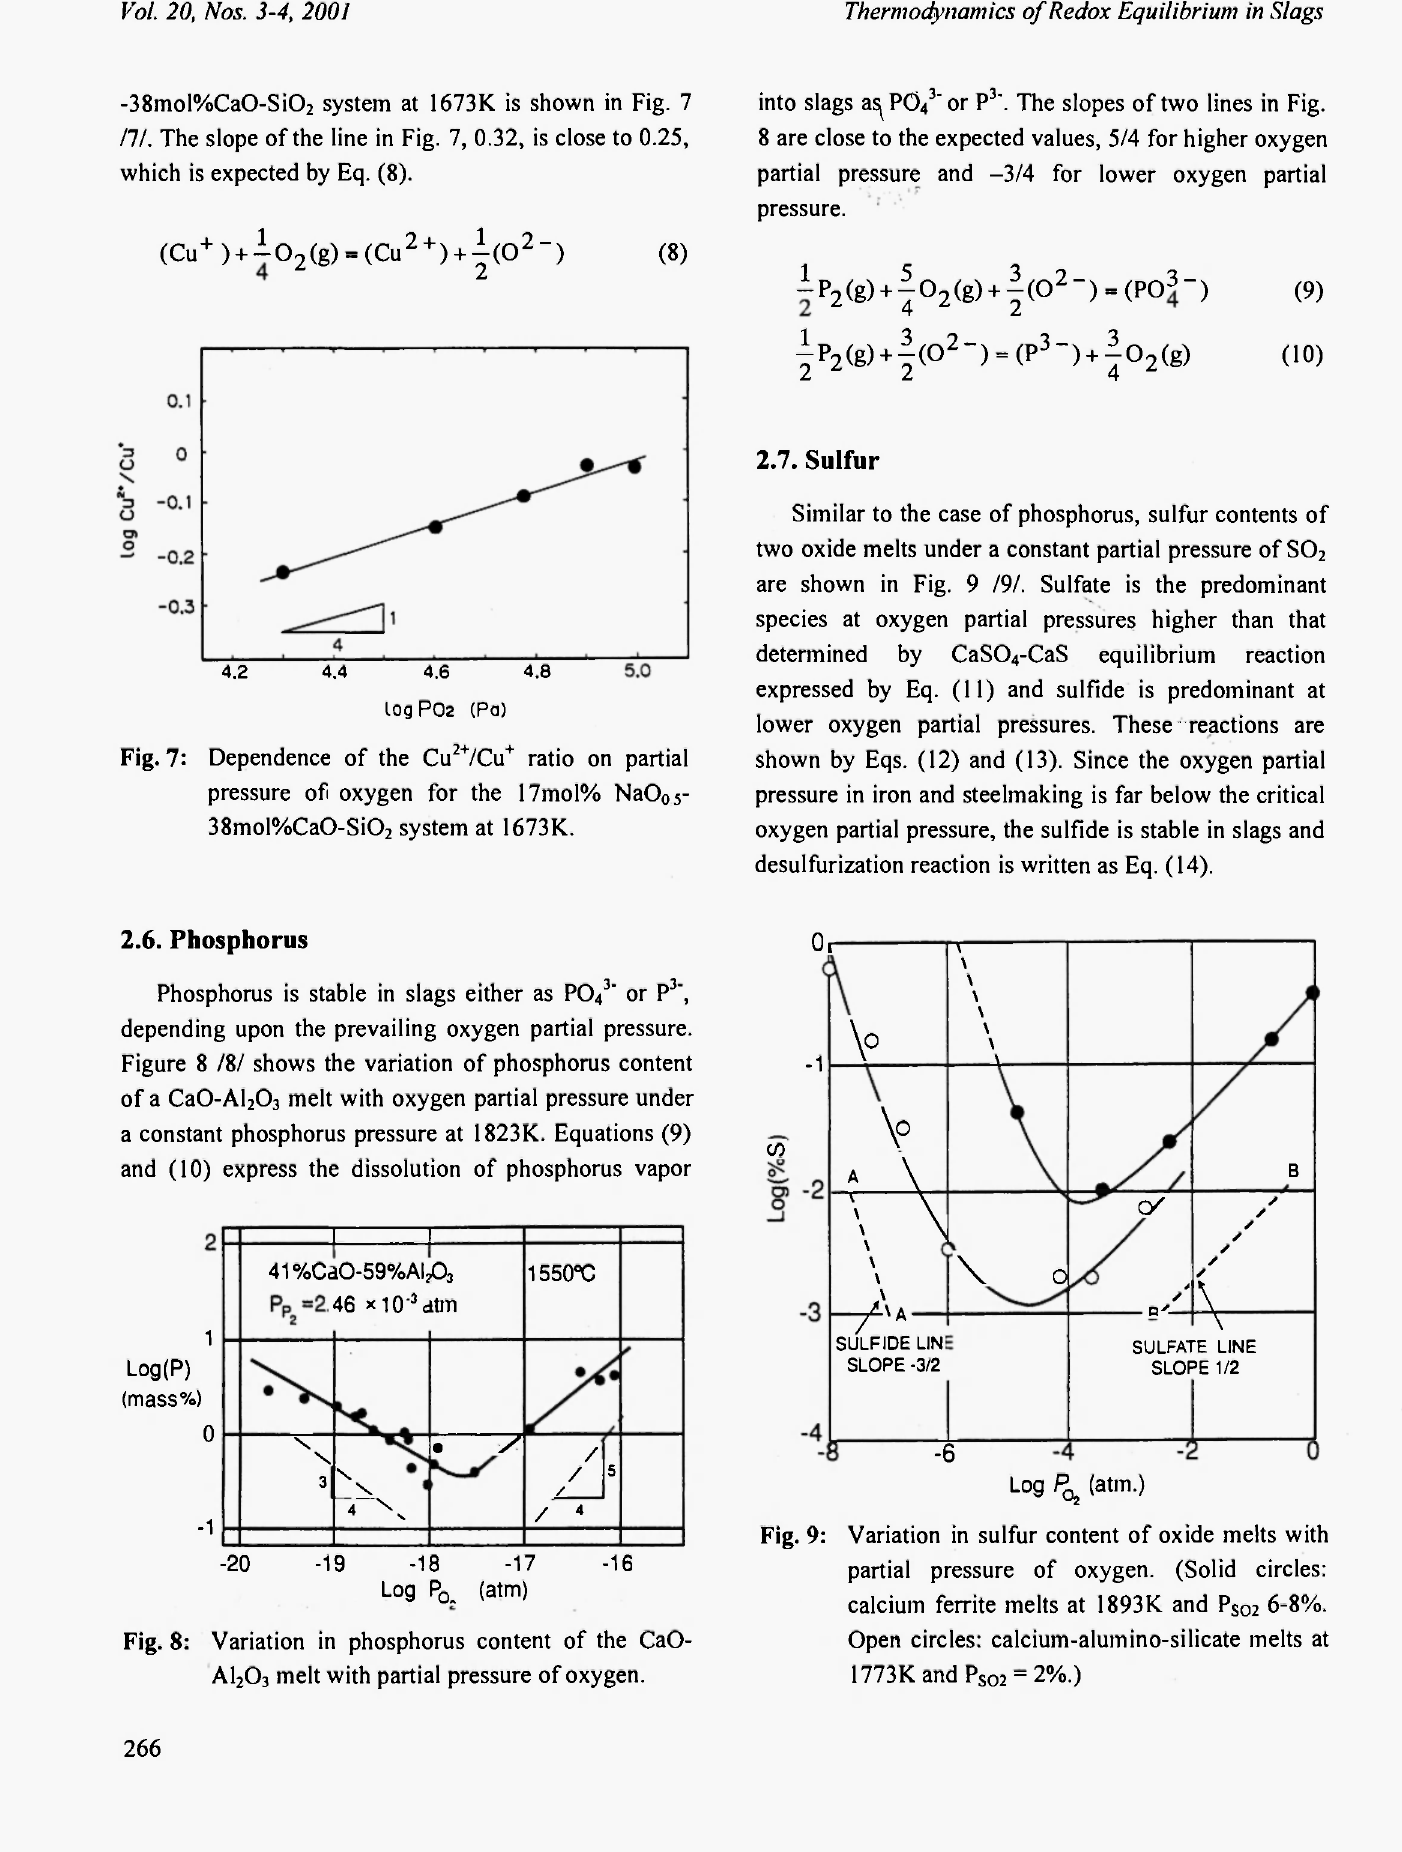
Fig. 9: Variation in sulfur content of oxide melts with partial pressure of oxygen. (Solid circles: calcium ferrite melts at 1893 Κ and P S o 2 6-8%. Open circles: calcium-alumino-silicate melts at 1773KandP S0 2 =